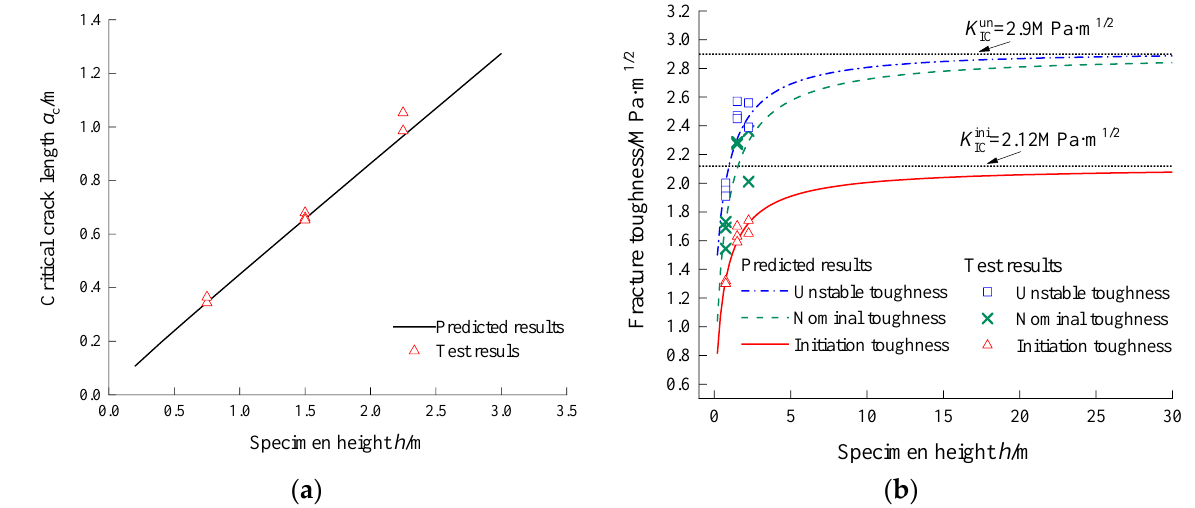
Figure 21. Critical crack length and fracture toughness of specimens with different sizes: ( a ) critical crack length; ( b ) fracture toughness.